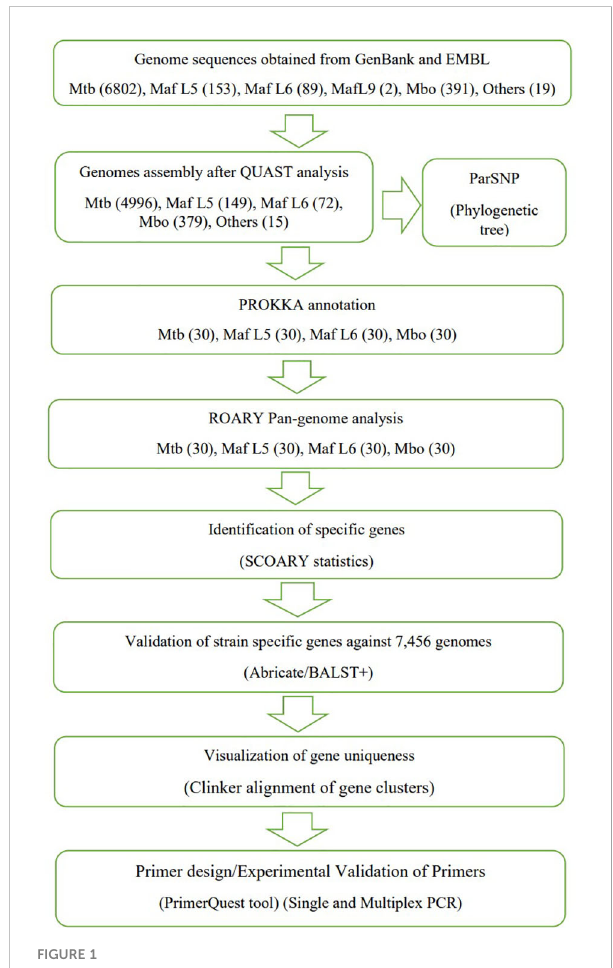
FIGURE 1 An overview of Scheme of work towards identi fi cation of lineage- speci fi c genes for PCR primers development (similar to comparative genomic work fl ow previously described by Akwani et al.,